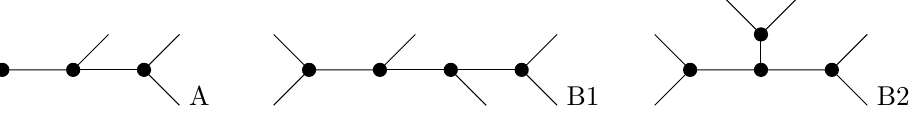
Figure 2 . Order 5 unlabelled tree